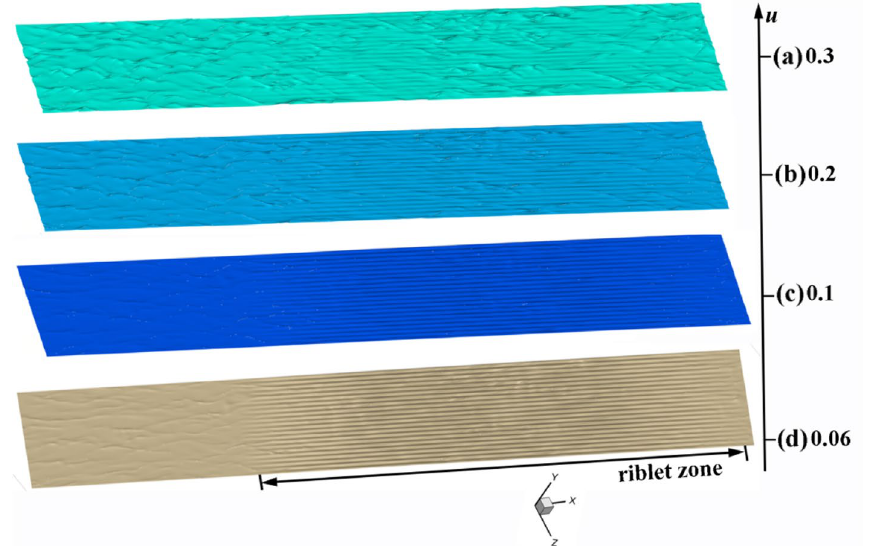
Fig. 23 Three-dimensional iso-surface distributions of streamwise velocity